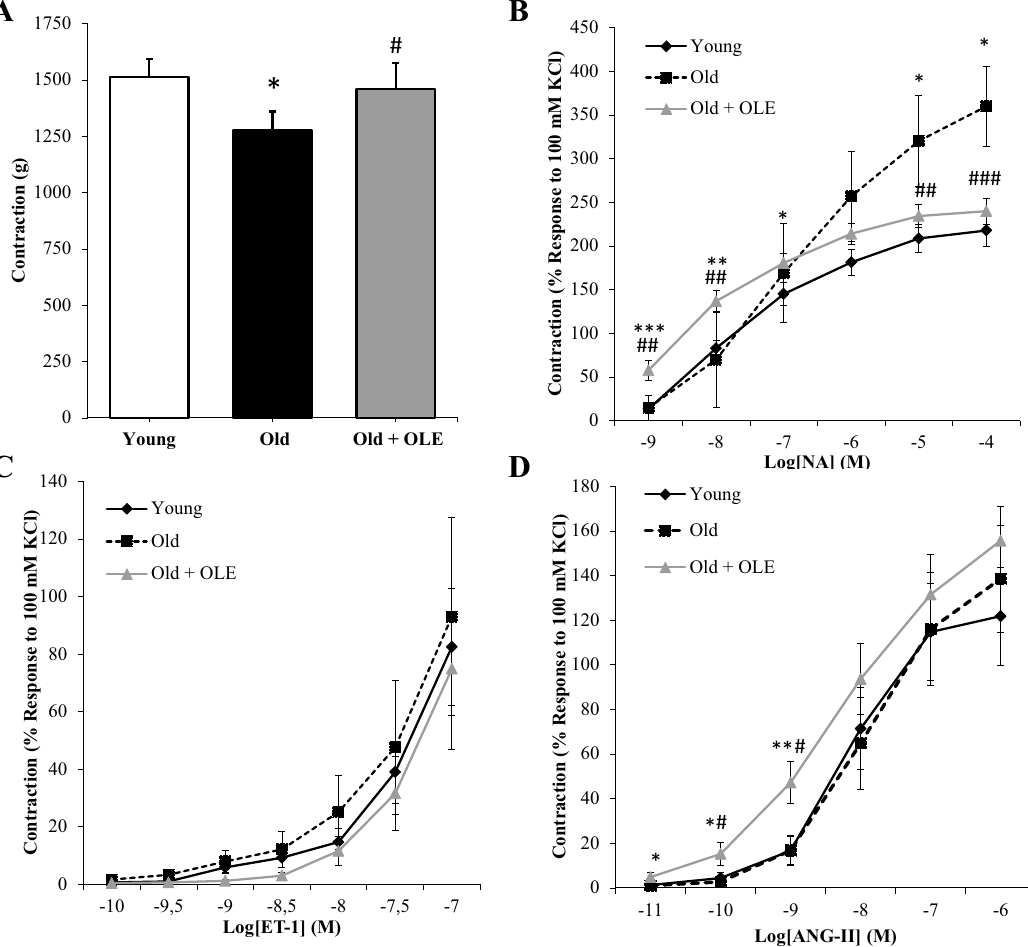
Figure 4. Effects of aging and a 21-day treatment with the OLE on the contraction response of abdominal aortic segments to potassium chloride 100 mM ( A ), norepinephrine ( B ), endothelin-1 ( C ) and to angiotensin-II ( D ). Values are represented as mean ± SEM. * p < 0.05 vs. Young; ** p < 0.01 vs. Young; *** p < 0.001 vs. Young; # p < 0.05 vs. Old; ## p < 0.01 vs. Old; ### p < 0.001 vs. Old.